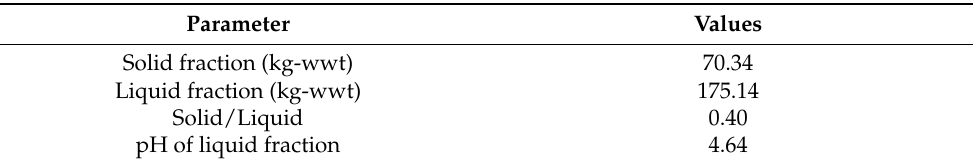
Table 1. Mass balance of the steam-exploded Ludwigia grandiflora at 180 ◦ C for 30 min at a severity factor of 3.8.